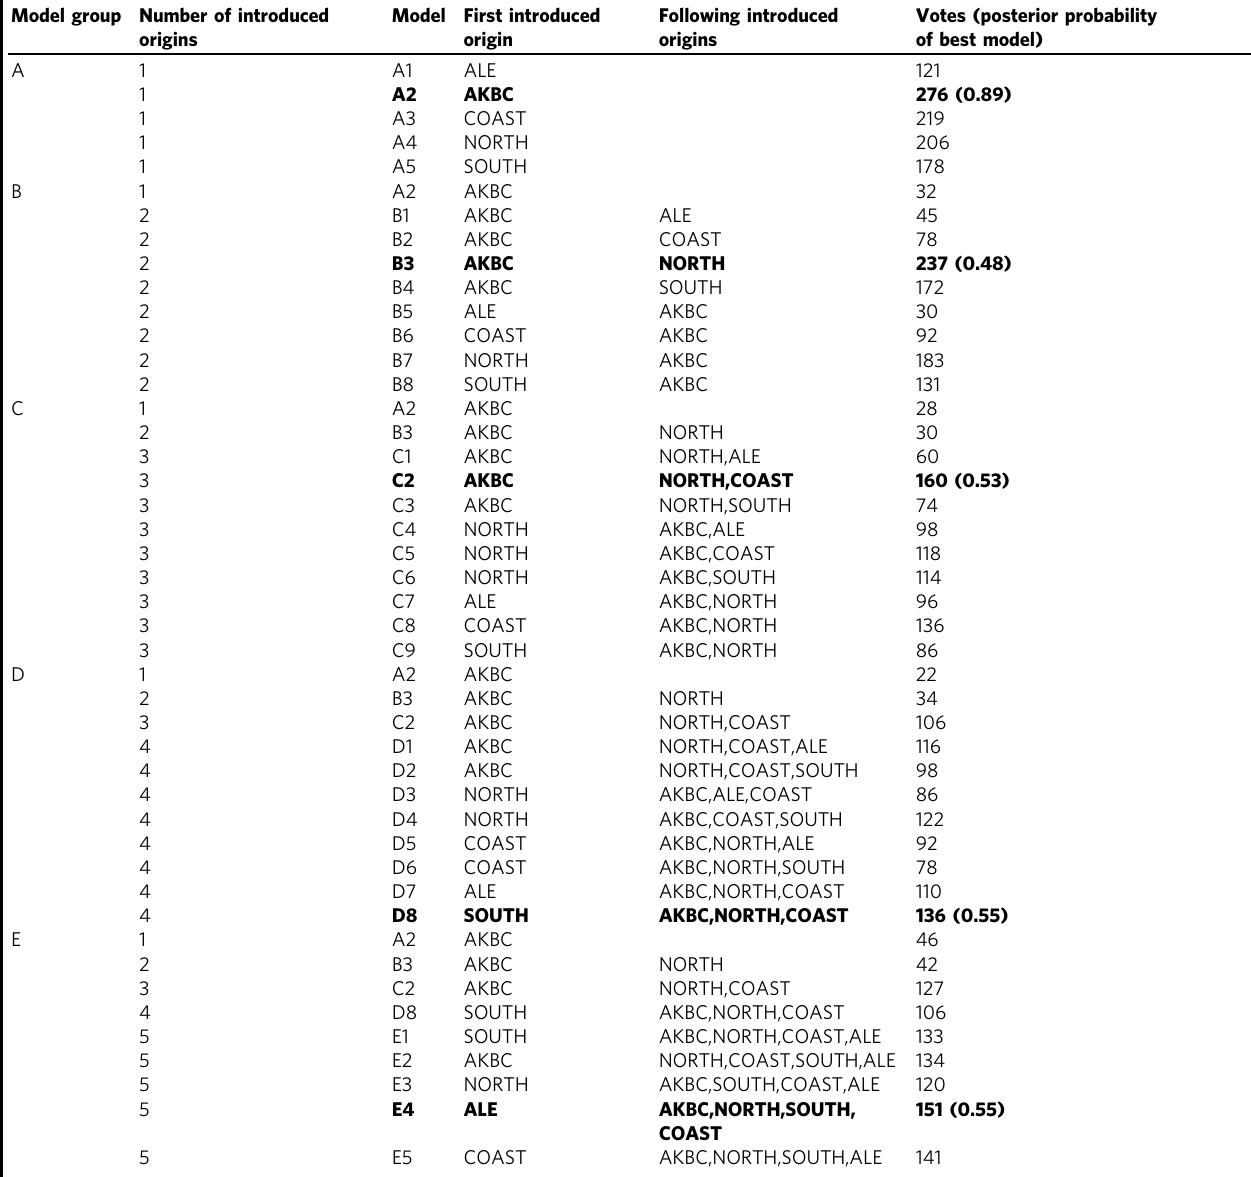
Table 1 Comparison of demographic models of the invasion of Mimulus guttatus into the United Kingdom. Model group Number of introduced